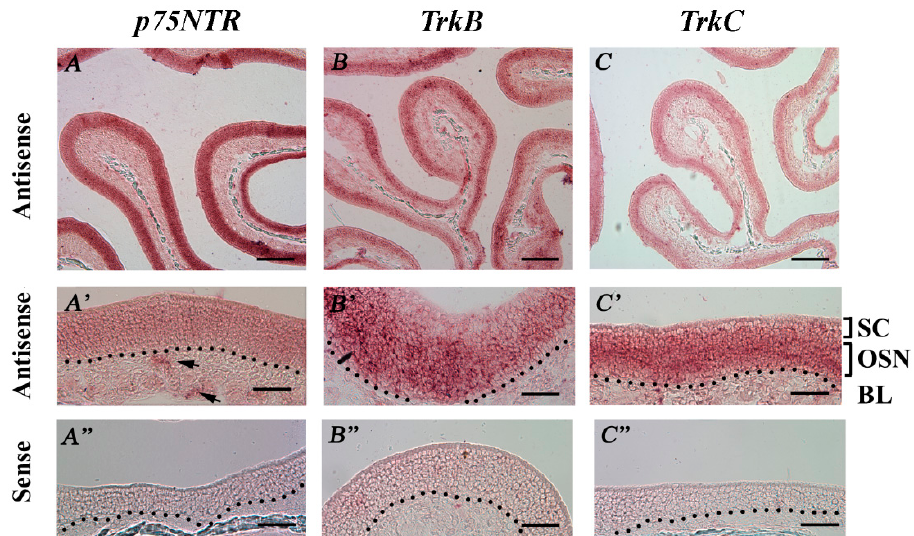
Figure 7. RISH analysis of NTR mRNA expression in the MOE of regularly housed TRPM5-GFP mice. ( A – C ) Low-magnification (10 × ) images showing labels of the antisense probes against p75NTR , TrkB , and TrkC . ( A’ – C’ ) High-magnification (40 × ) images of antisense probes, correlating with the top row of images. SC: sustentacular/supporting cell layer, OSN: olfactory sensory neuron layer, BL: basal lamina—black dotted line. ( A” – C” ) High-magnification (40 × ) images showing hybridization of the sense probe against p75NTR, TrkB , and TrkC . Arrows in A’ point to presumed ensheathing cells in the lamina propria. No specific signal was observed for the tested sense probes. Scale bars: ( A – C ) 200 μ m; ( A’ – C’’ ) 50 μ m.